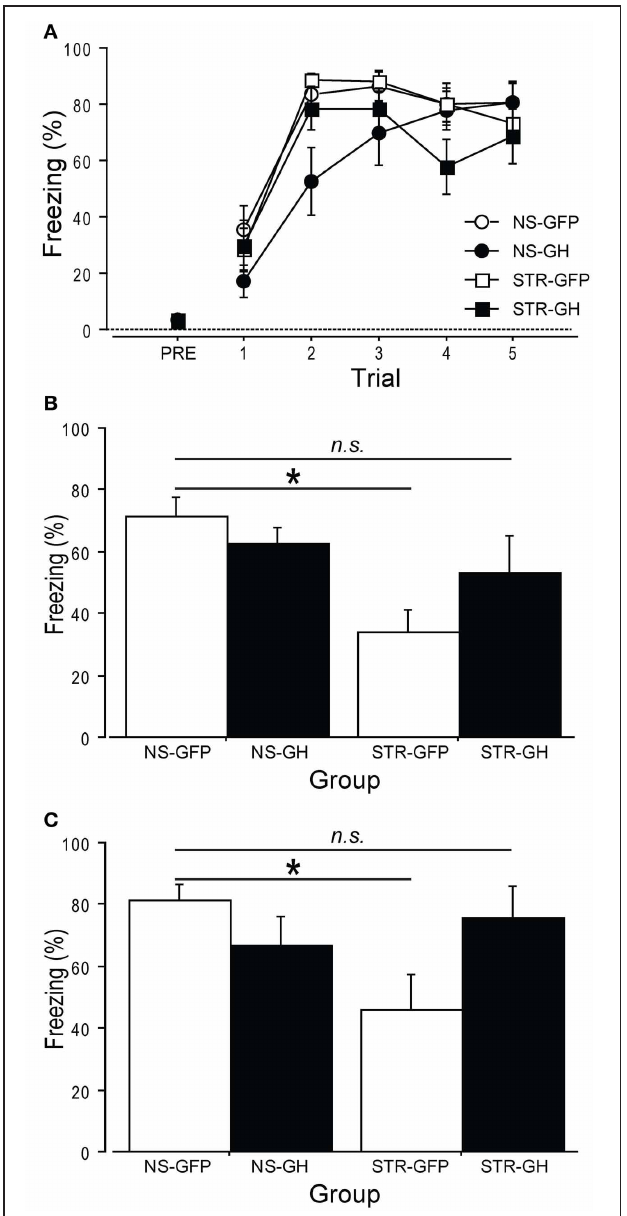
FIGURE 3 | Overexpression of hippocampal GH rescues stress-related impairments in auditory trace conditioning. Two weeks of daily immobilization stress (STR) or handling (NS) were administered to rats. Twenty-four hours after the last session, GH or GFP virus was infused bilaterally into the dorsal hippocampus. (NS-GFP, n = 9; NS-GH, n = 7; STR-GFP, n = 7; STR-GH, n = 6). (A) After three days of recovery, auditory trace conditioning was administered. Neither stress nor GH administration affected conditional freezing during training. (B) Long-term contextual fear memory was measured the next day by returning rats to the conditioning context for 5m. Stress impaired contextual fear memory, and intra-hippocampal GH expression partially reversed this impairment. (C) Long-term auditory fear memory was measured the following day by placing the rats in a novel context and presenting four tones in the absence of footshock. Stress impaired auditory fear memory, and intra-hippocampal GH expression fully reversed this effect. ∗ Indicates p < 0 . 05 in a post-hoc comparison.